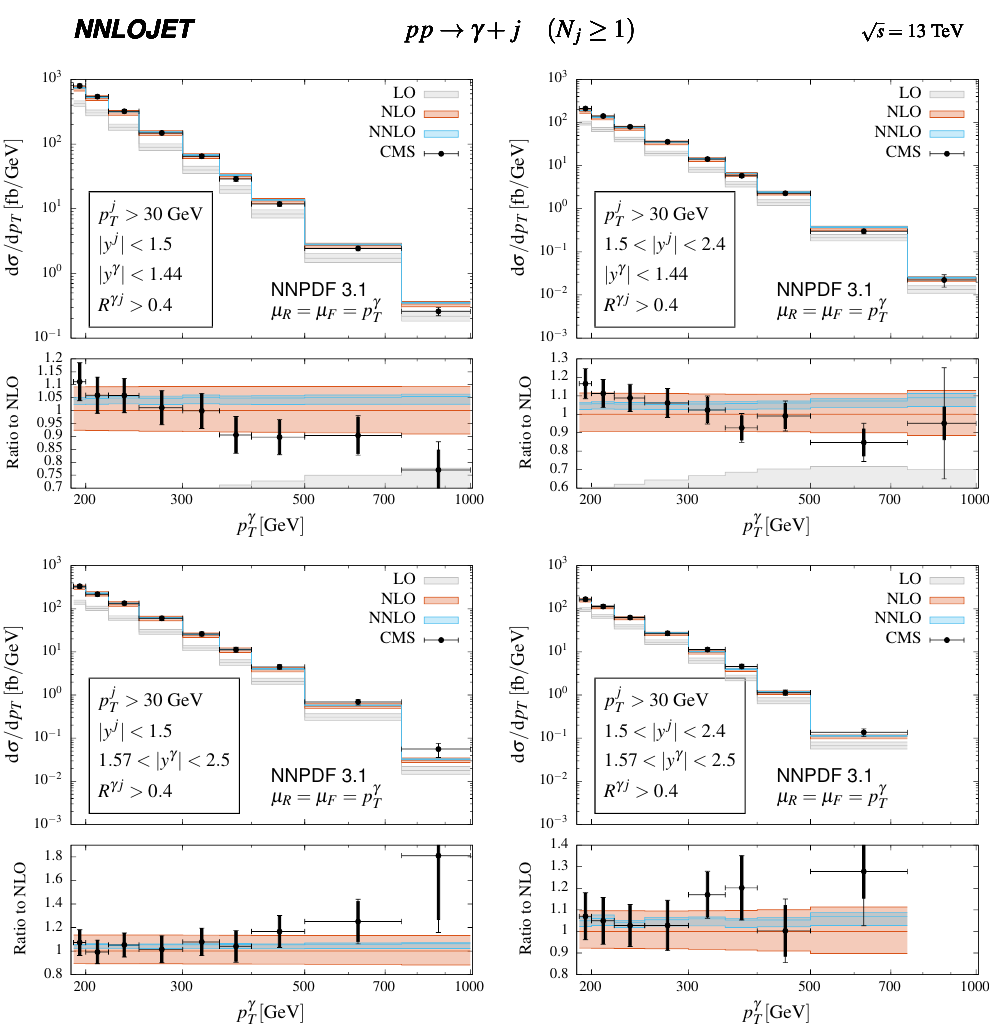
Figure 17 . Transverse energy/momentum distribution of the photon at LO, NLO and NNLO in two di(cid:11)erent rapidity bins for the photon and the leading jet, each. The results are compared to CMS data [12]. Note that the data has been multiplied by the corresponding rapidity bin-widths, as CMS presents the data in triple-di(cid:11)erential form in ( p (cid:13) ; y (cid:13) ; y j T